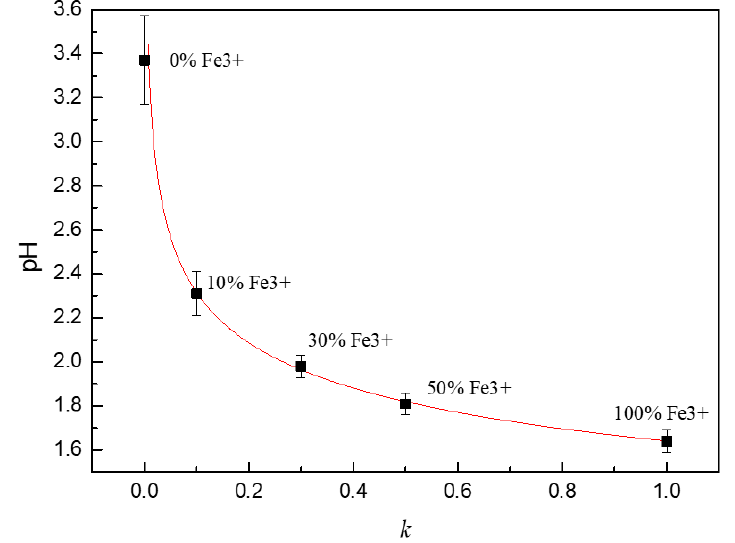
Figure 6. The pH value of solutions with different proportions of Fe 2+ /Fe 3+ .